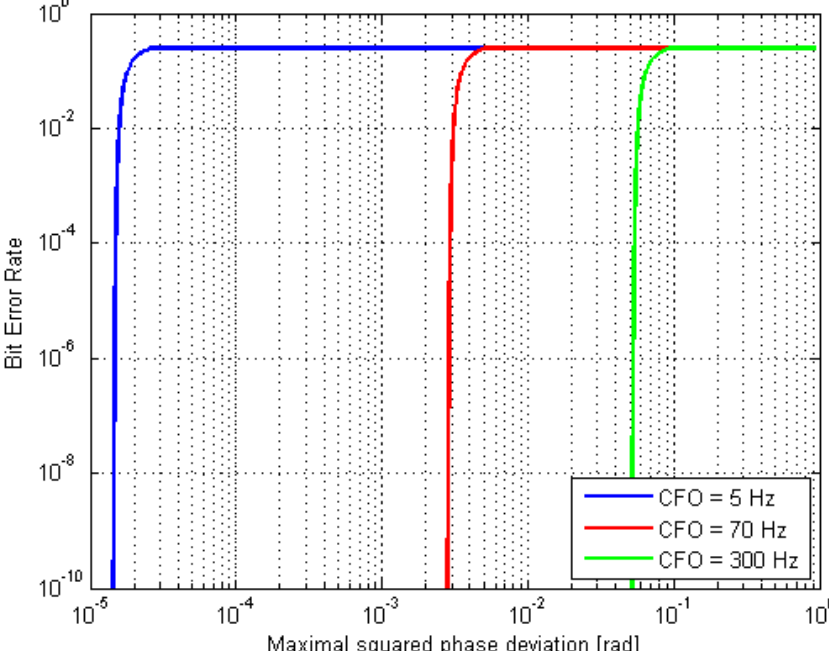
Figure 2. Bit error rate (BER) vs. maximal carrier frequency offset (CFO)-made phase deviation; 16 quadrature amplitude modulation (QAM), 10 dB high-power amplifier (HPA) back-off.